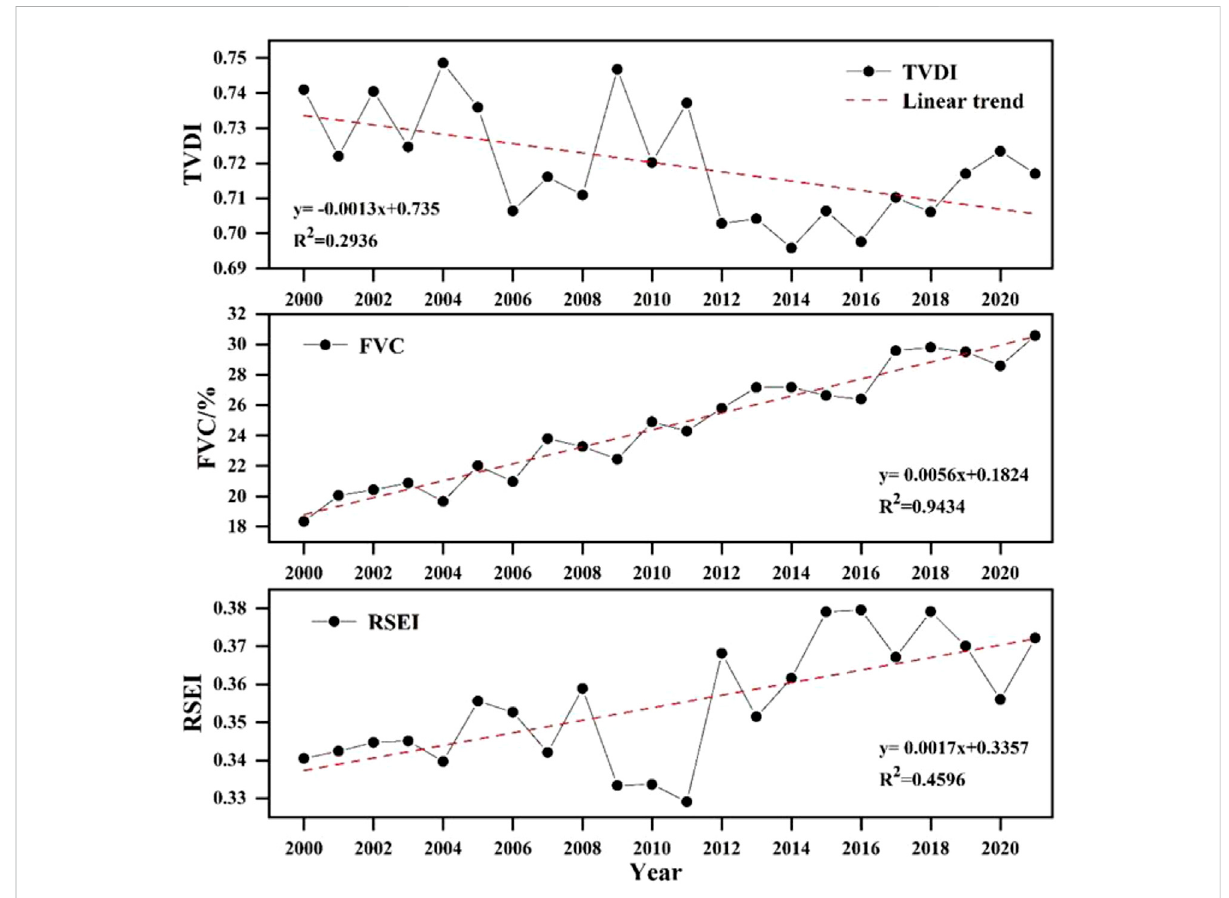
FIGURE 7 Variation trends of annual average TVDI, annual average FVC, and annual average RSEI in the Tarim River Basin from 2000 to